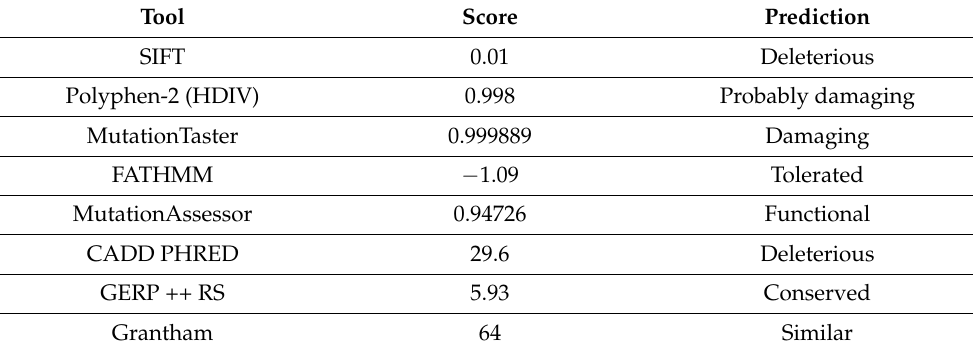
Table 1. Bioinformatic Tools Predict the POLR2A p. V456A Variant is Deleterious. Tool Score Prediction SIFT 0.01 Deleterious Polyphen-2 (HDIV)